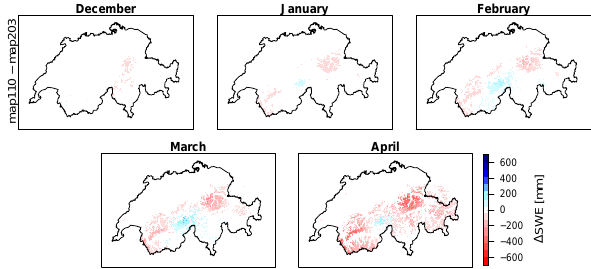
Fig. 6. The mean differences (map110–map203) per grid cell for